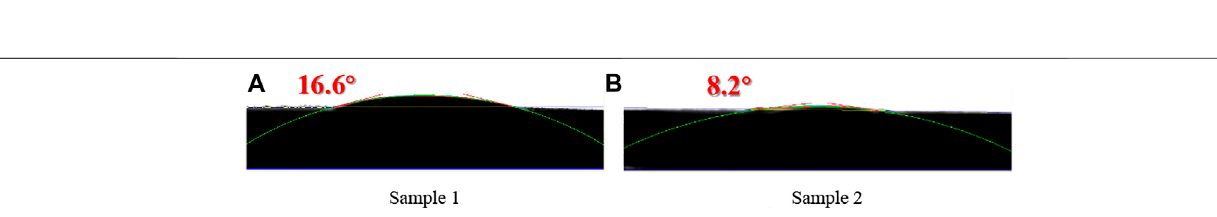
FIGURE 2 | Results of mercury injection test of our samples. (A) Capillary pressure curves. (B) Pore size distribution curves